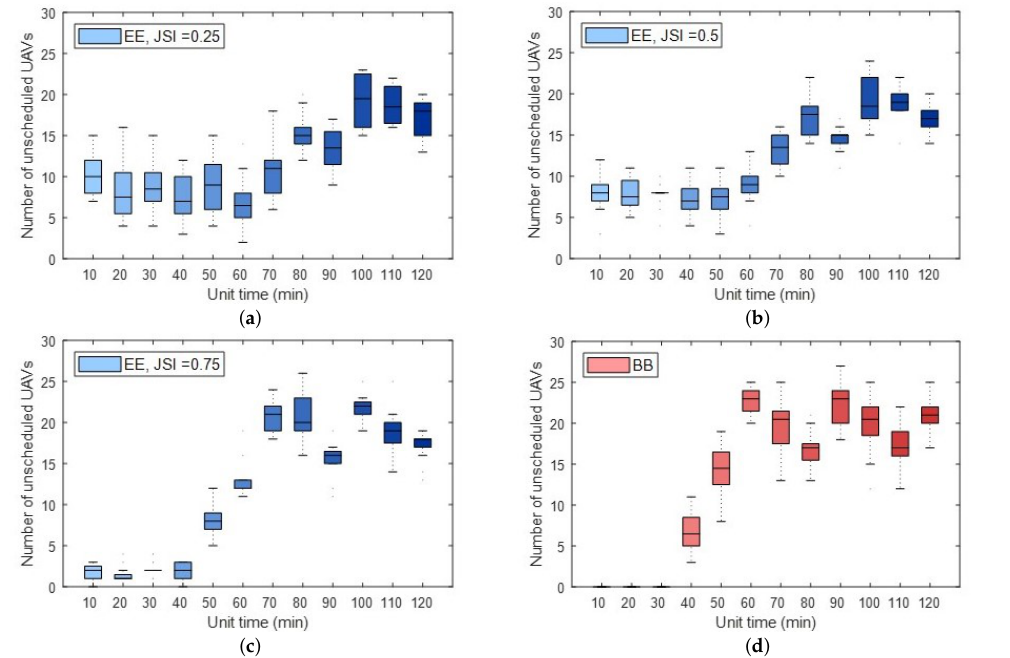
Figure 4. ( a ) EE algorithm, JSI = 0.25. ( b ) EE algorithm, JSI = 0.5. ( c ) EE algorithm, JSI = 0.75. ( d ) BB algorithm. The number of unscheduled UAVs for the proposed EE algorithm (JSI = 0.25, JSI = 0.5, and JSI = 0.75), and BB algorithm (Scenario 3: 20 F-UAVs, 10 M-UAVs). Table 4. Standard deviation ( σ ) of the number of unscheduled UAVs for both proposed algorithms, EE and BB (Scenario 3: 20 fixed UAVs (F-UAVs), 10 moving UAVs (M-UAVs)). Proposed EE